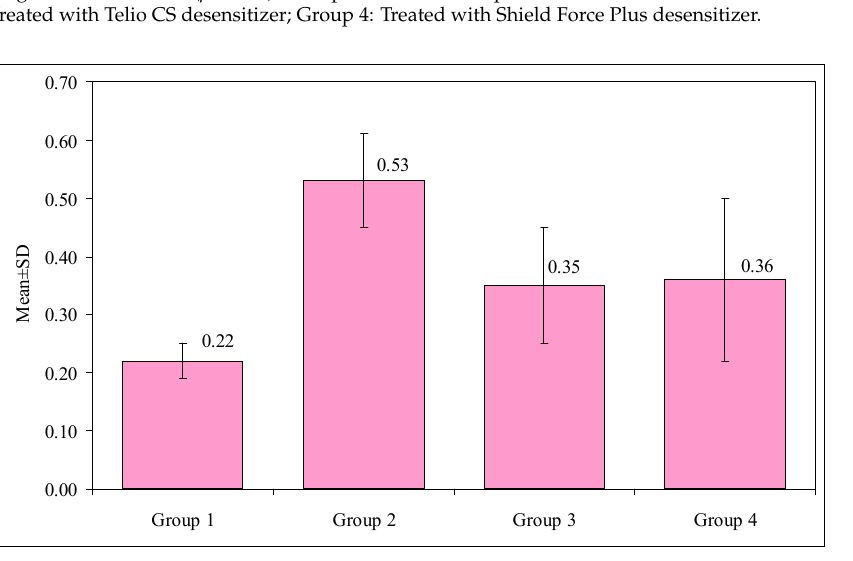
Table 7. Inter-group comparison of the mean values of the tensile strengths using the post hoc Bonferroni test.